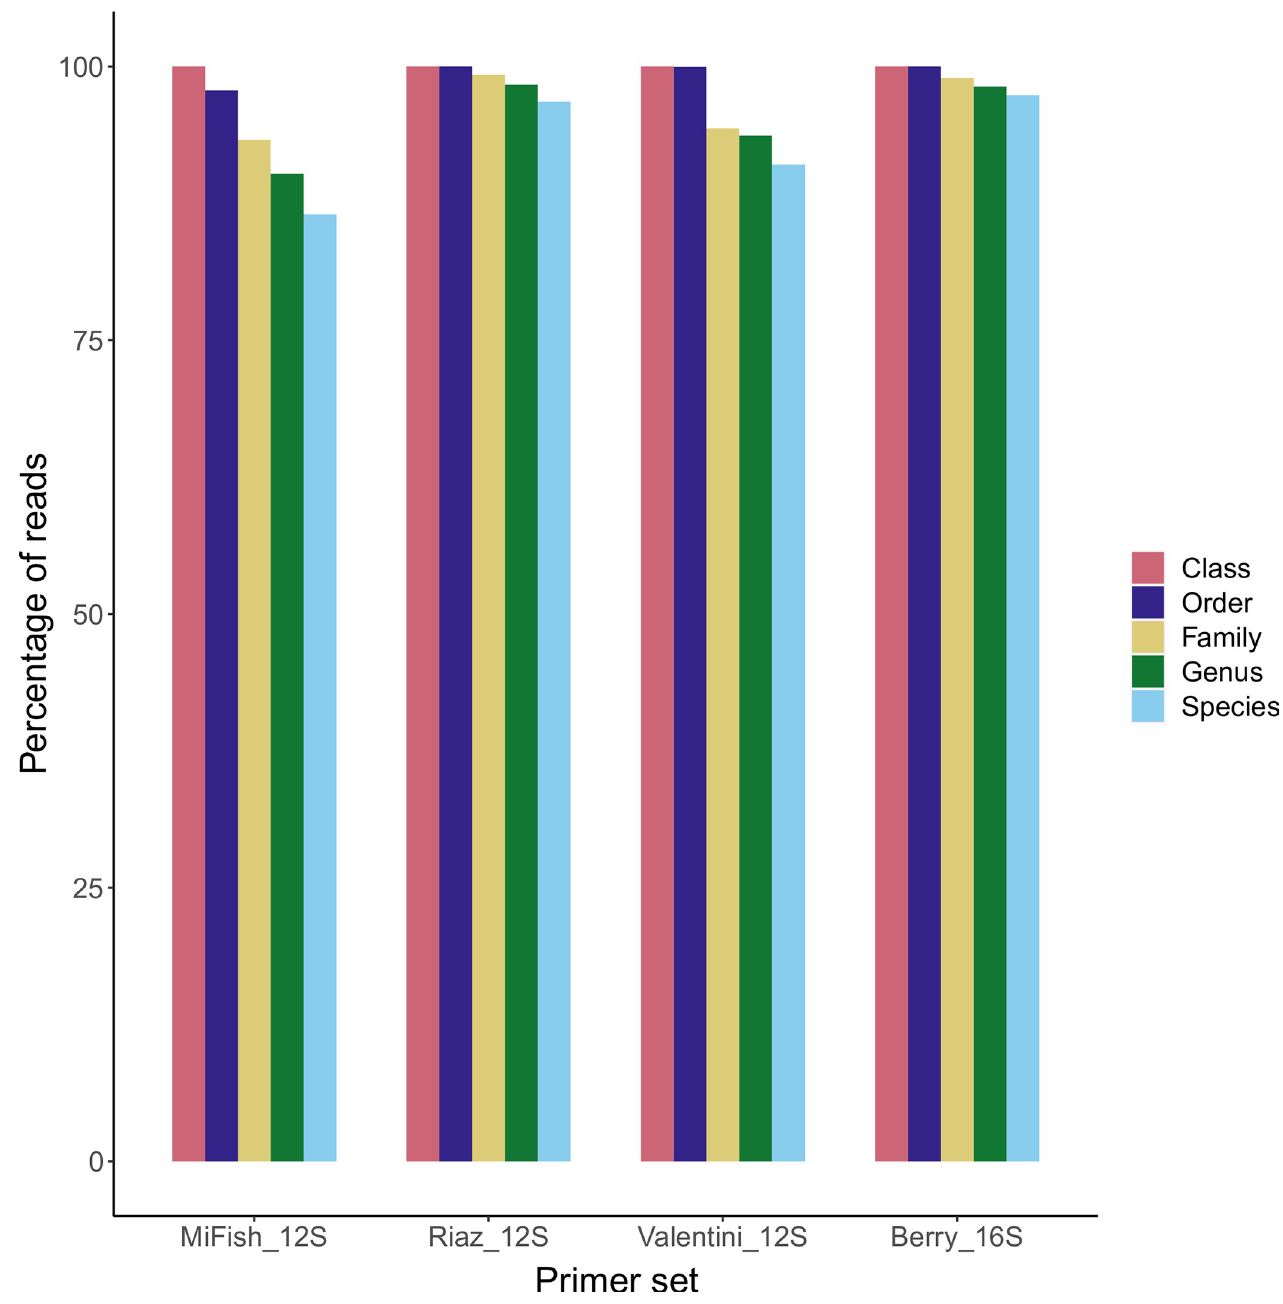
Fig 1. Proportion of reads assigned to each taxonomic level for the four metabarcoding primer sets tested here.